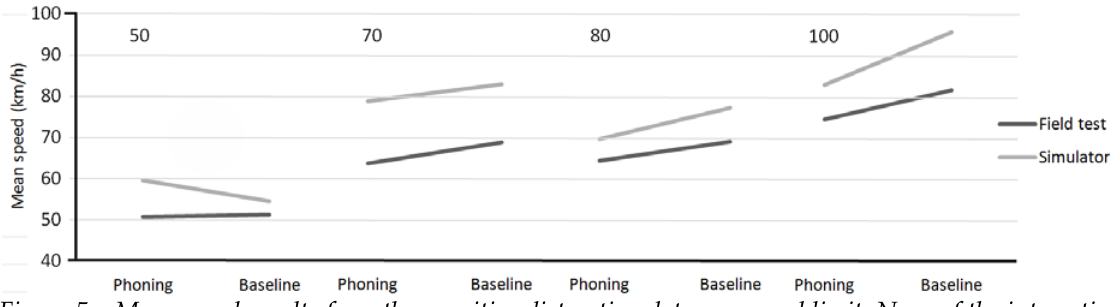
Figure 5a. Mean speed results from the cognitive distraction data, per speed limit. None of the interactions was significant at α=.05.